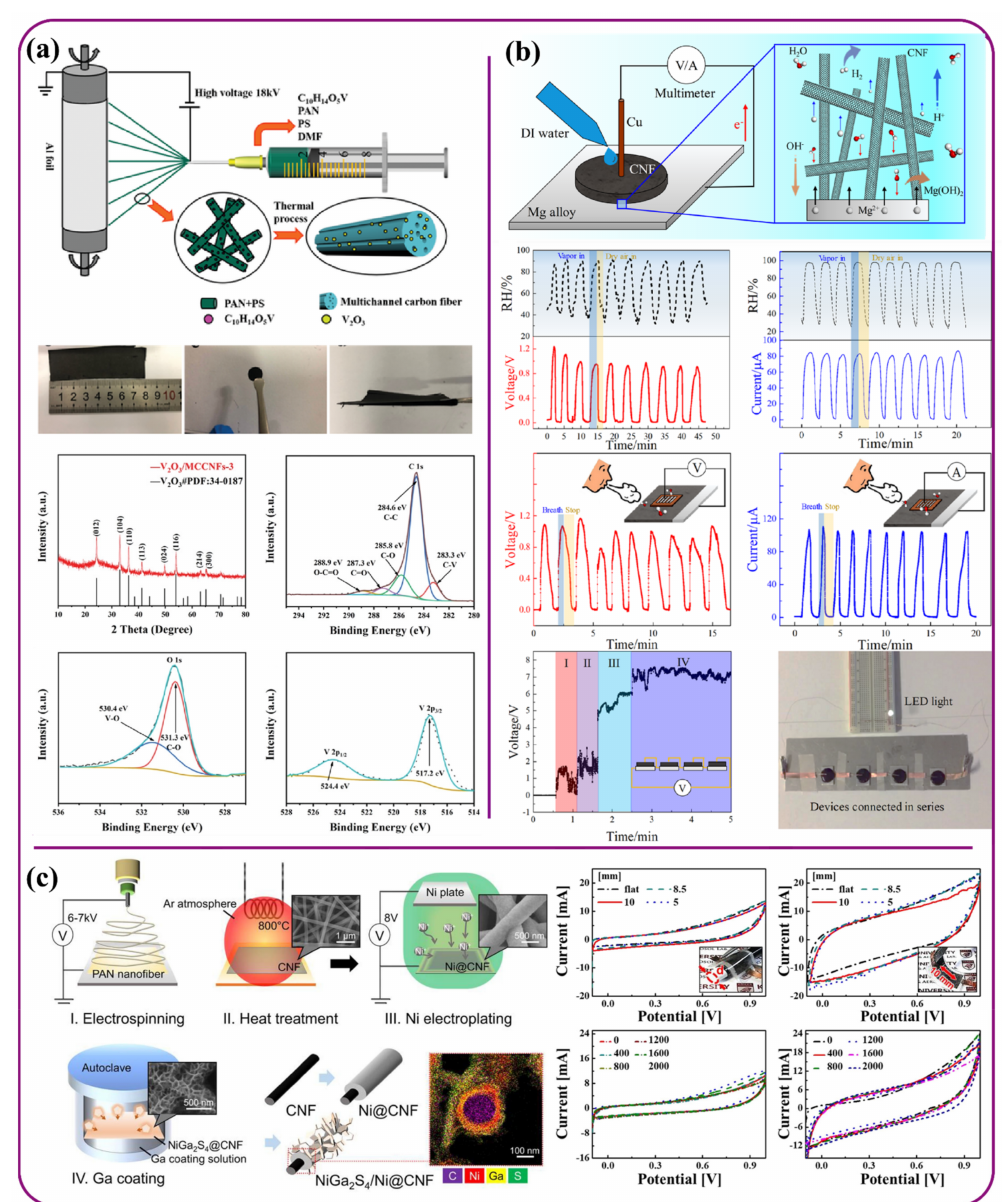
Figure 8. ( a ) Schematics on formation process of V 2 O 3 /MCCNFs composites; free-standing films prepared by electrospin- ning; displaying flexibility and 180 ◦ folding films [167]. ( b ) Illustration of the device used for water detection, as well as the Mg–water reactions and ion transportation happening in the CNF porous structure; pulse signals in response to relative humidity changes by the human breath detected by the device [169]. ( c ) Schematic of the stepwise fabrication process of NiGa 2 S 4 /Ni@CNF; electrochemical characteristics of flexible supercapacitors, CV curves with varying curvature radii (mm) with liquid and solid electrolyte